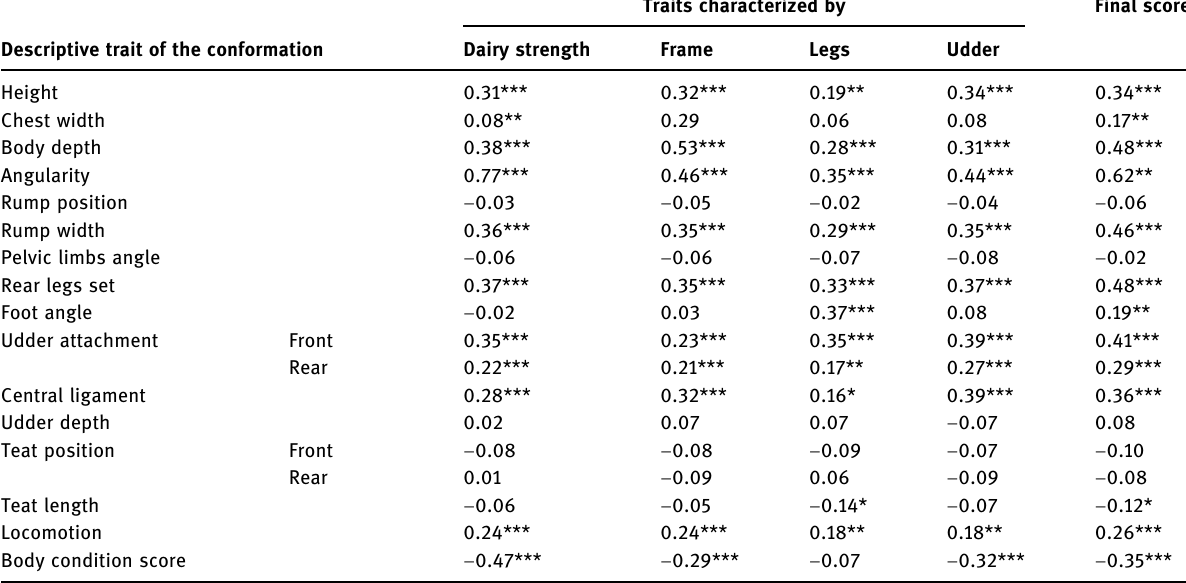
Table 3: The relationship level between scores of descriptive and group traits of cow ’ s linear classi fi cation of the Ukrainian Brown dairy